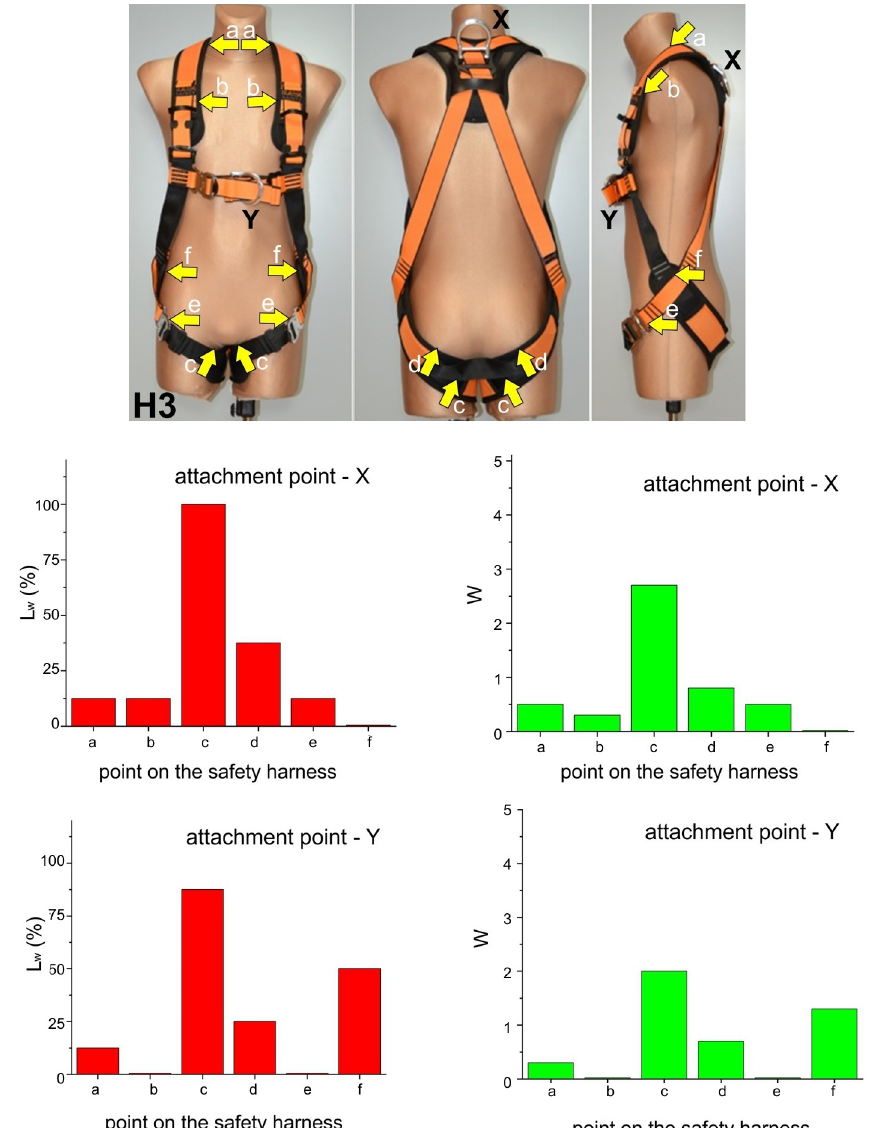
Figure 5. Test results for harness H3.